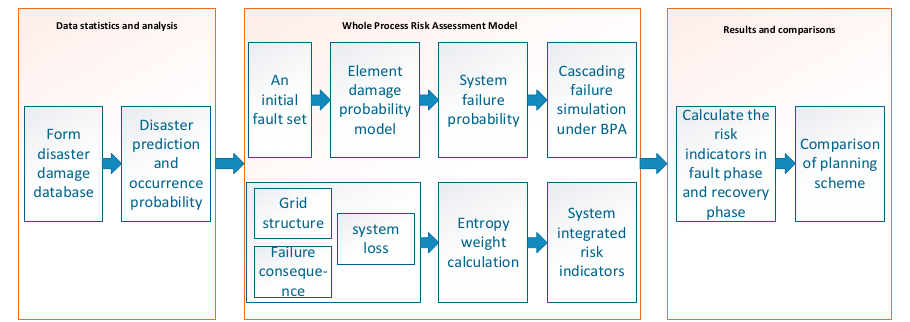
Figure 5. The calculation flow.